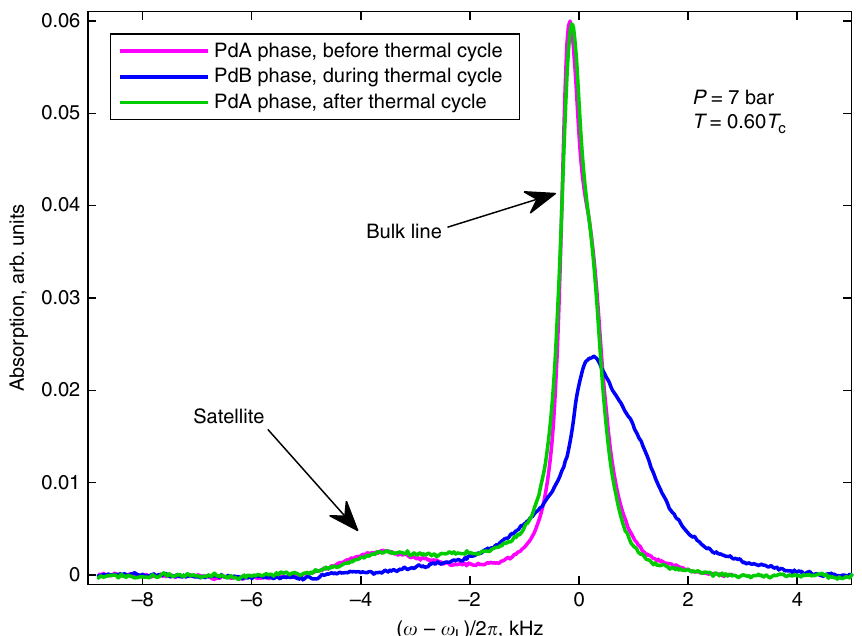
Fig. 2 Survival of HQVs during phase transitions. The plot shows the measured NMR spectra in transverse ( μ = π /2) magnetic fi eld in the presence of HQVs. HQVs were created by rotation with 2.5 rad s − 1 during the transition from normal phase to the polar phase. The NMR spectrum includes the response of the bulk liquid and the ^ d -solitons, which appear as a characteristic satellite peak at lower frequency. The satellite intensity in the PdA phase remains unchanged after thermal cycling presented in Fig. 1c. The NMR spectrum in the PdB phase at the same temperature, measured between the two measurements in the PdA phase, is shown for